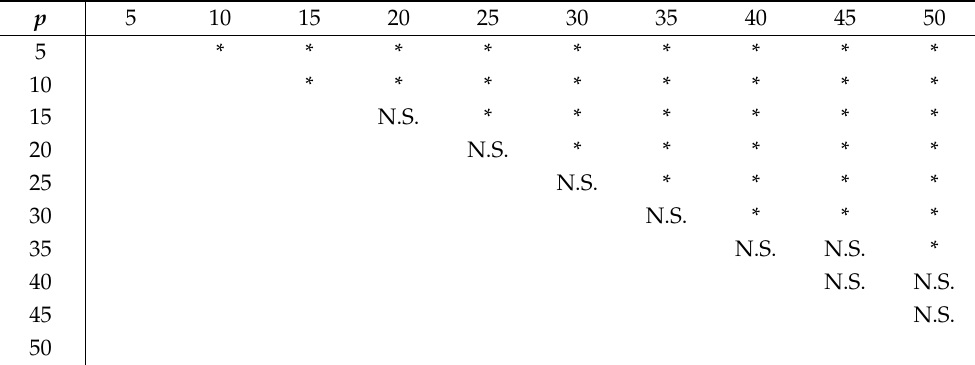
Table 7. Statistical significance in dryness perception for samples with a w value of 15 µ m for various p values. * Significance level < 0.05. N.S. means not